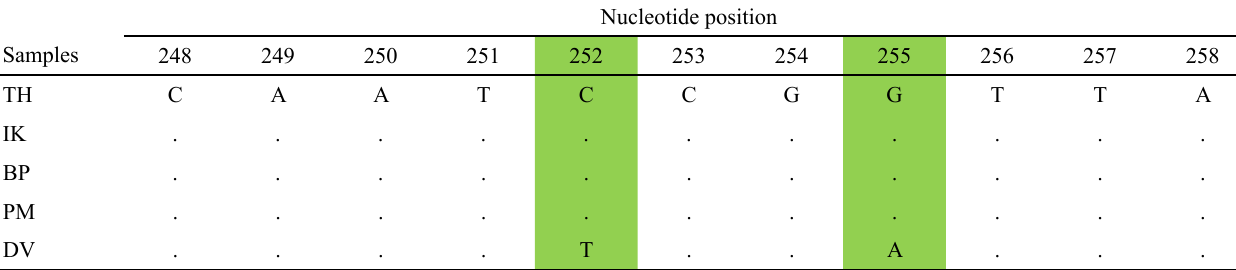
Fig 2 . Neighbor-Joining tree built on the partial COII gene sequences of G. sulphureus from five different mounds. C. gestroi is used as an outgroup. The number at the branch refers to the bootstrap value. The evolutionary distances are computed using the p-distance method. Bar = 0.02 substitutions per nucleotide Table 3 . Aligned haplotype sequences showing polymorphic sites (highlighted in green color).